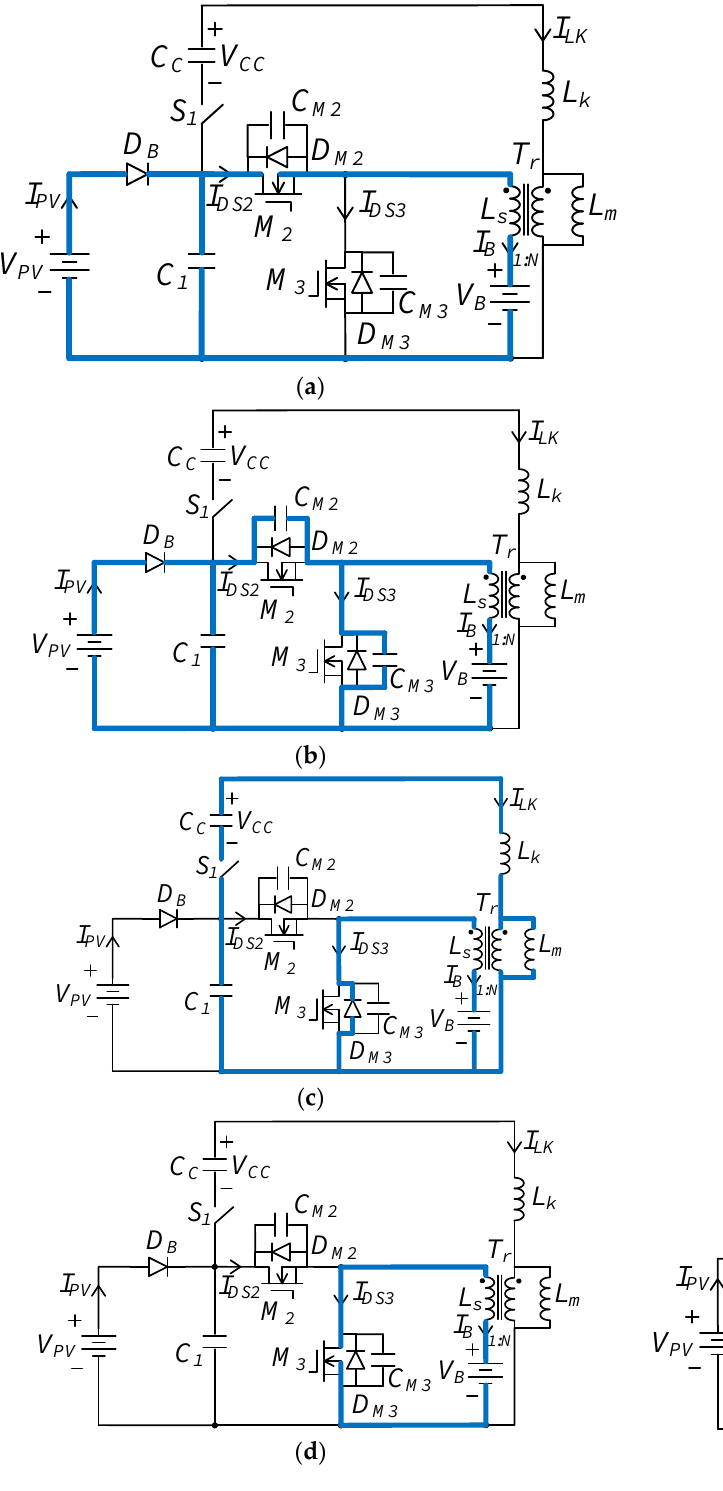
Figure 7. Equivalent circuit of each operational mode of the proposed hybrid converter operated in PV arrays source condition over a complete switching cycle. ( a ) Mode1 ( t 0 ≤ t ≤ t 1 ), ( b ) Mode2 ( t 1 ≤ t